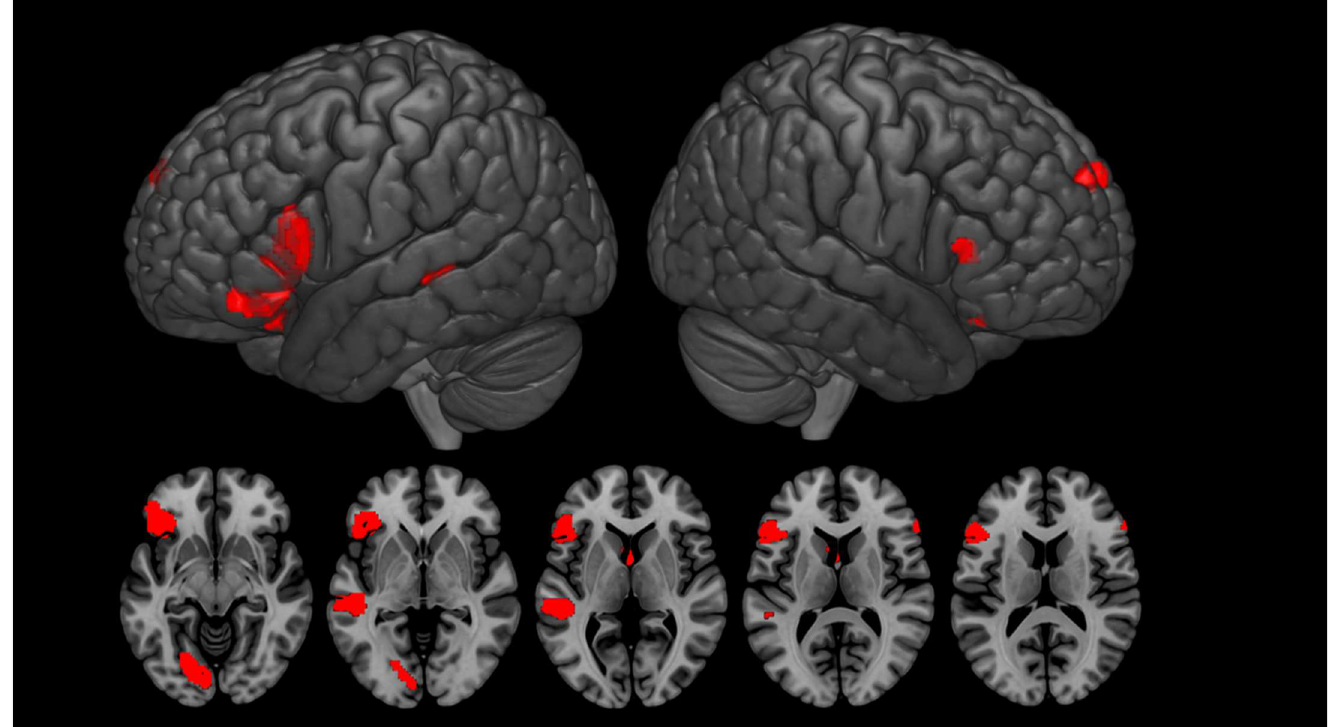
Fig 2. Activation for the Irony > Literal comparison. p < 0.001 uncorrected, k = 20 voxels. Differenceswere observed in the bilateral inferior frontal gyrus, left superior temporalgyrus, lingualgyrus caudate, and bilateralmedialsuperiorfrontal